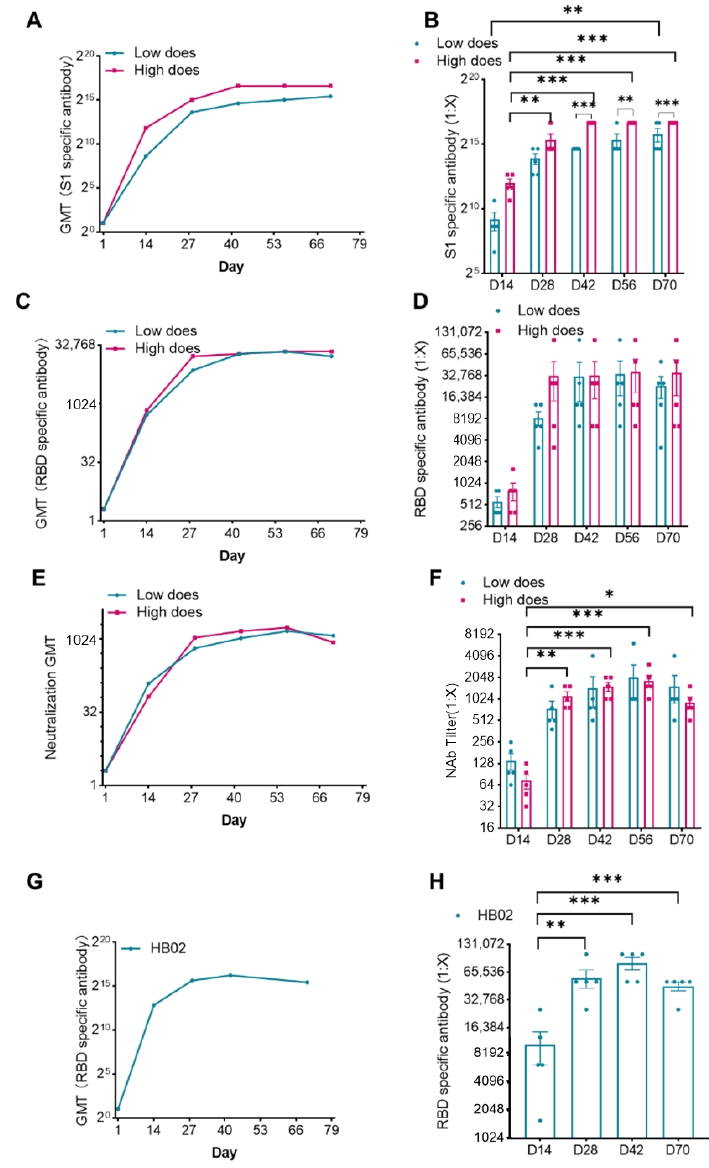
Figure 5. The immunogenicity analysis of the Omicron inactivated vaccine. The SD rats were injected with the vaccines on D1, D15, D29, and D43, and the serum was collected on D0, D14, D28, D42, D56, and D70 for the immunogenicity analysis. ( A , B ) The Omicron S1-antigen-specific anti- bodies in serum were analyzed by ELISA. The GMT of Omicron S1-antigen-specific antibodies at different time points (D0, D14, D28, D42, D56, D70) in the Omicron vaccine-immunized rats are shown in ( A ). The statistical analysis of the Omicron S1-antigen-specific antibody levels in the Omi- cron vaccine-immunized rats is shown in ( B ); ( C , D ) The Omicron RBD-antigen-specific antibodies in serum were analyzed by ELISA. The GMTs of the Omicron RBD-antigen-specific antibodies at different time points (D0, D14, D28, D42, D56, D70) in the Omicron vaccine-immunized rats are shown in ( C ), and the statistical analysis of Omicron RBD-antigen-specific antibody levels in Omi- cron vaccine-immunized rats are shown in ( D ); ( E , F ) The neutralization antibody (NAb) titer in the Omicron vaccine-immunized rats detected by CPE. The GMTs of the neutralization antibody titer at different time points (D0, D14, D28, D42, D56, D70) in the Omicron vaccine-immunized rats are shown in ( E ). The statistical analysis of the GMT of neutralization antibody titer in each group is shown in ( F ); ( G , H ) The HB02-RBD-antigen-specific antibody in serum were analyzed by ELISA.